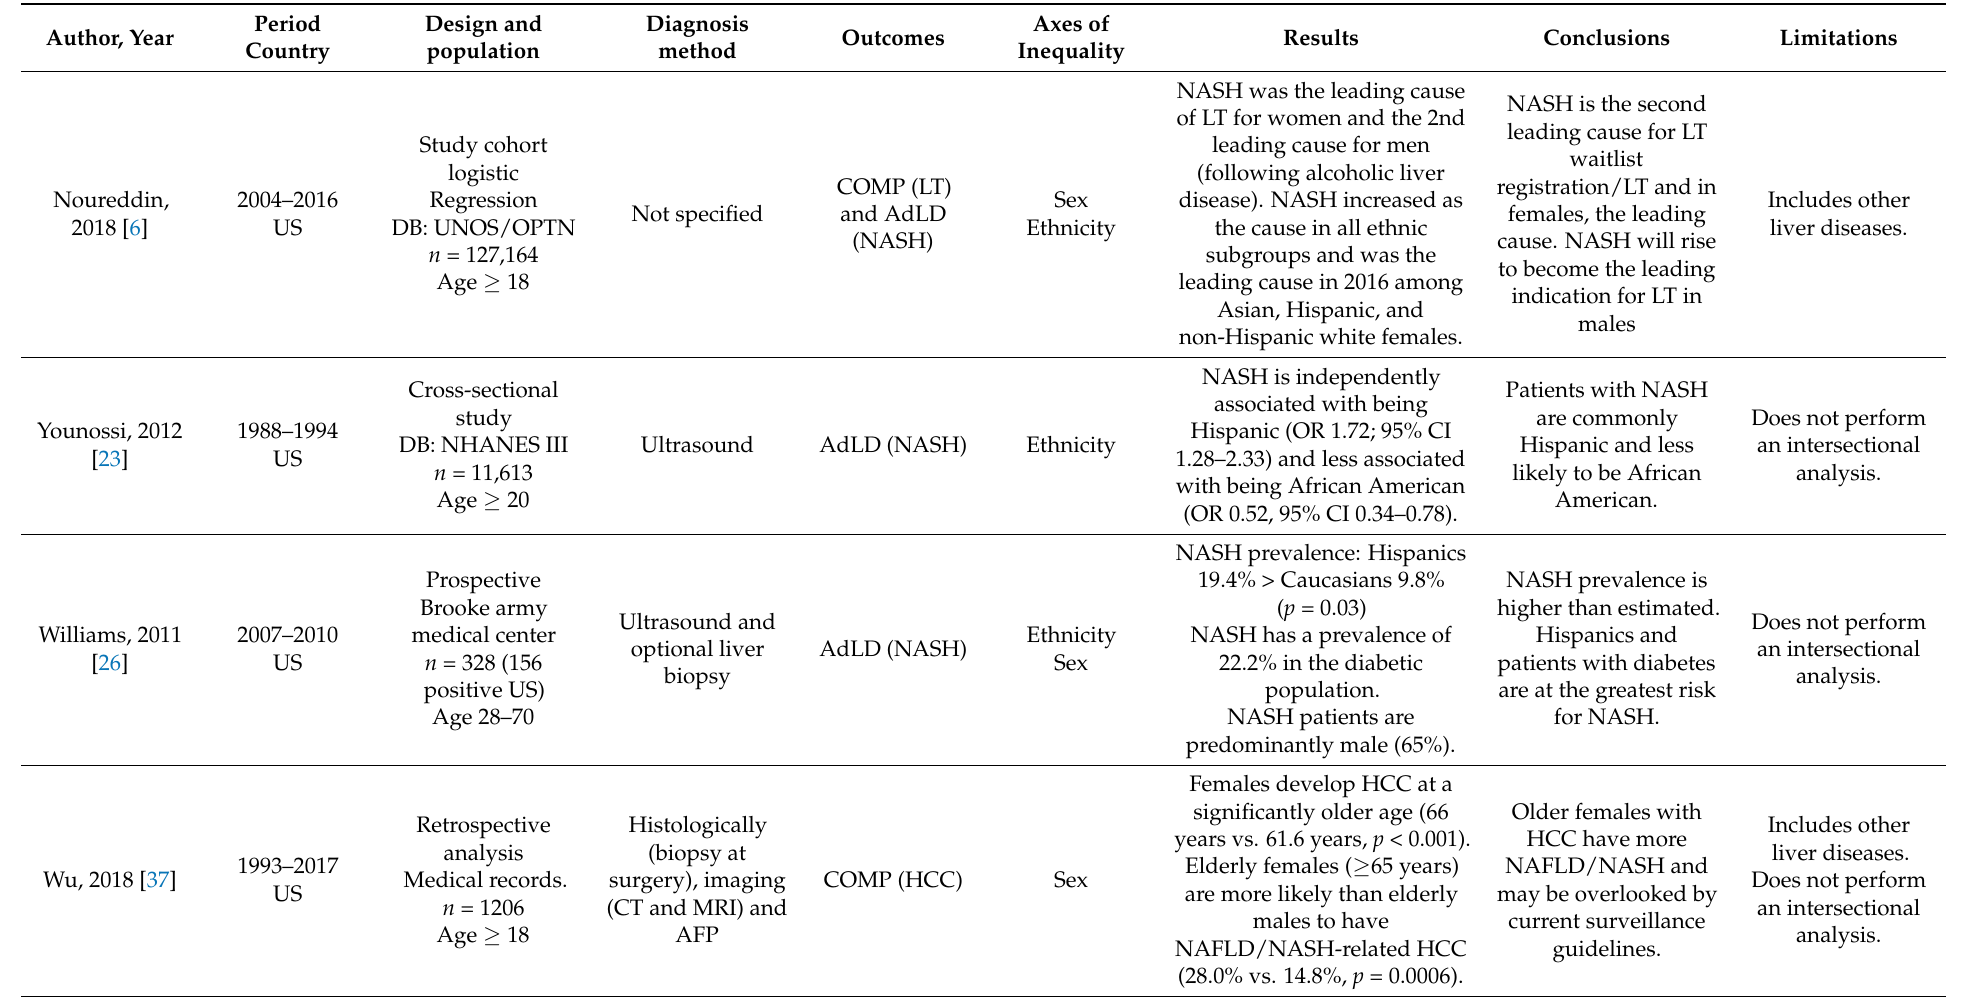
Table 2. Summary of included studies assessing NAFLD